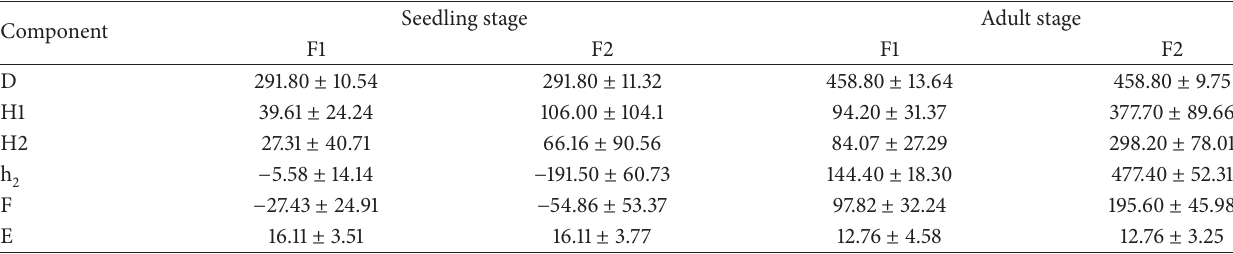
Table 12: Genetic